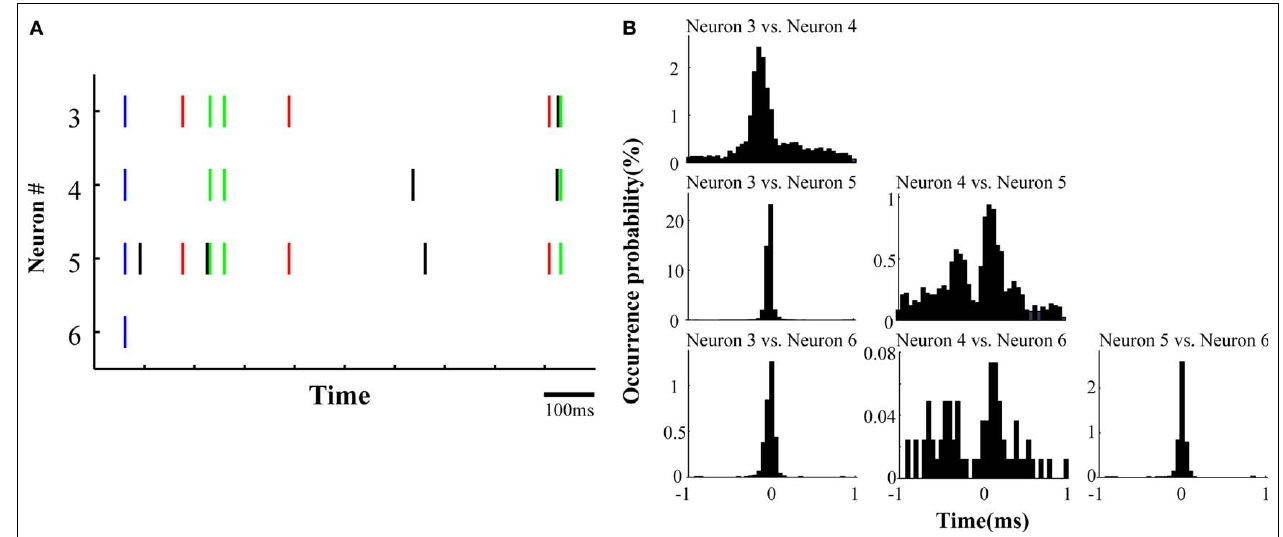
FIGURE 3 | Sub-millisecond synchronizations among closely neighboring neurons. (A) Spike rasters of four pyramidal neurons recorded from one dodecatrode for a 1-s data segment. Possible coincidences within a 1-ms range are color-coded (Black, no coincident